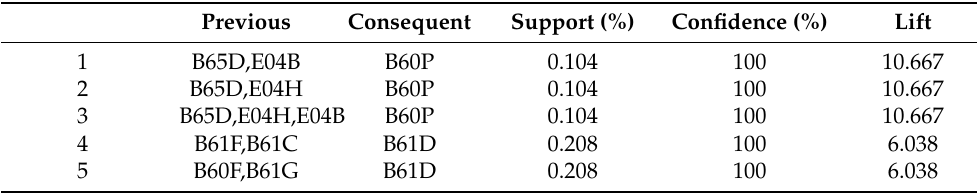
Table 6. The association rules for the 9th patent vacuum.